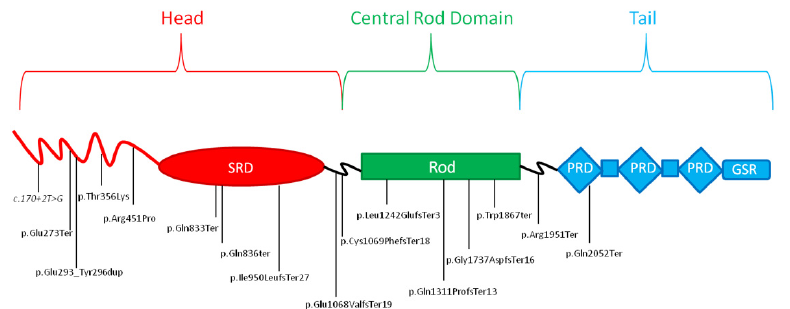
Figure 4. Schematic representation of the main structural domains of the desmoplakin protein and relative position of the genetic variants reported in this study. Splicing variant reported in italics. SRD:Spectrin repeat domain; PRD:plakin repeat domains; GSR:glycine/serine/arginine ‐ rich domain.